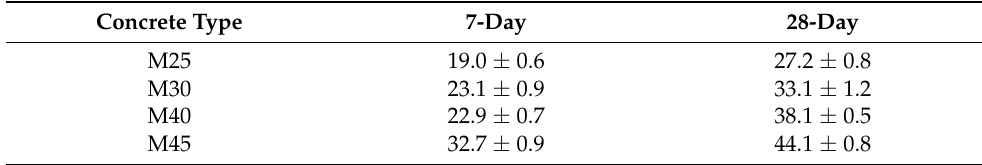
Table 7. Measured compressive strength